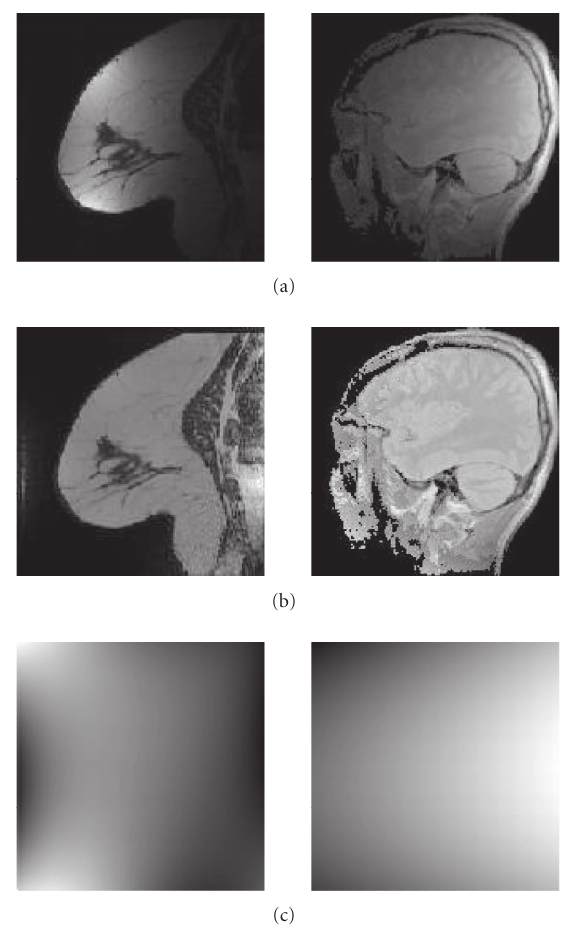
Figure 1: Sample MR images with severe intensity inhomogeneity: original images (a), corrected images (b), and estimated inhomo- geneity maps (c).